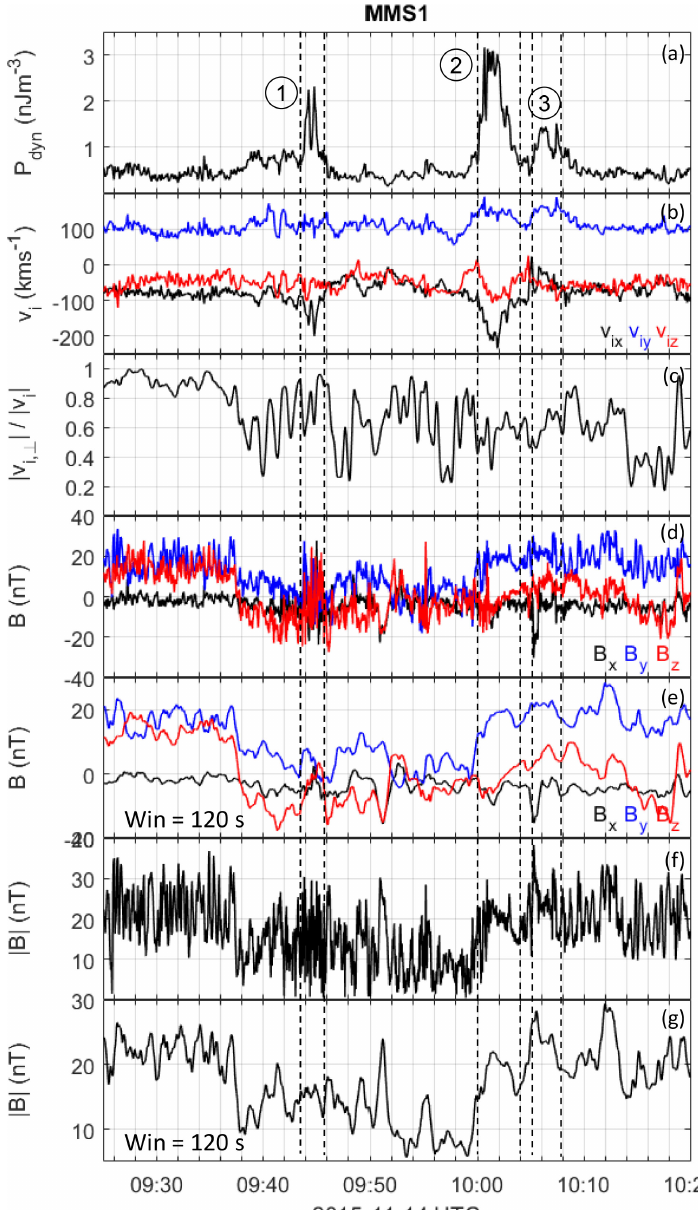
Figure 5. Magnetic field configuration. From top to bottom: dynamic pressure, ion velocity, ratio of perpendicular velocity to absolute velocity, magnetic field, magnetic field smoothed with a 120s window, magnitude of magnetic field, and magnitude of magnetic field smoothed with a 120s